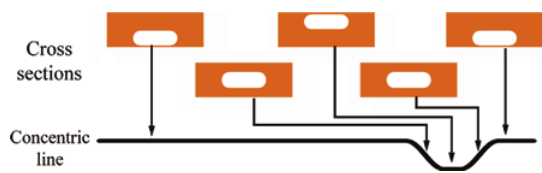
Figure 8: Cross sections of mixed